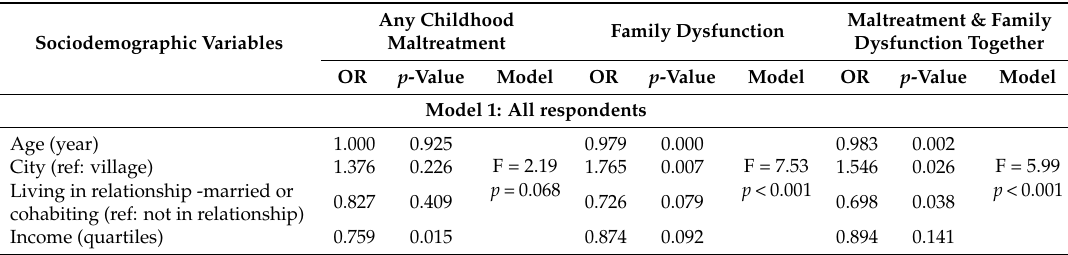
Table 5. Independent determinants of experiencing any of the five types of maltreatment or five types of dysfunctions in the family (Model 1).